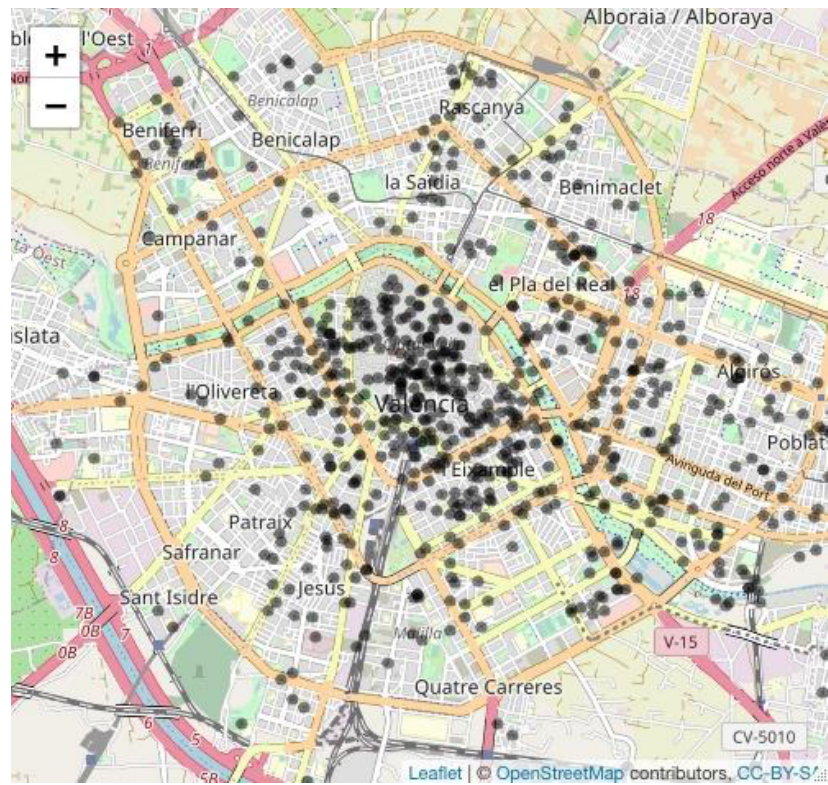
Figure 2. Simulated data: geolocation of the policyholders of the insurance company. Interactive map available at : https://go.uv.es/vcoll/cumulus_1 (accessed on 31 May 2021). The main descriptive statistics of the sum insured are shown in Table 1. Table 1. Descriptives of the sum insured.